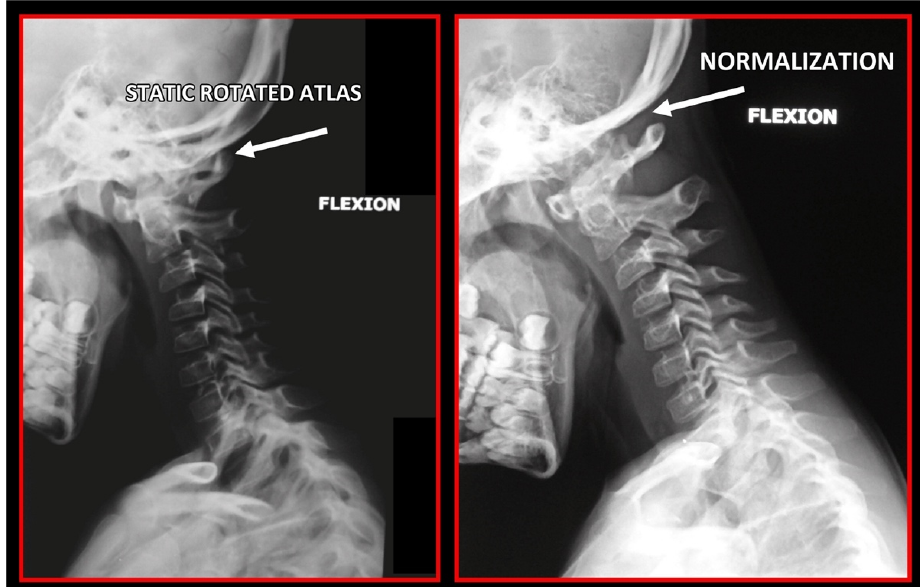
Figure 11. Rotation of the atlas on lateral cephalometric radiograph. Left: Pre-treatment. Double ring of the atlas showing its rotation. Decreased functional spaces. Right: After orthopedic manual therapy. Only one posterior arch of atlas showing normalization of atlas rotation. Normalized functional spaces.